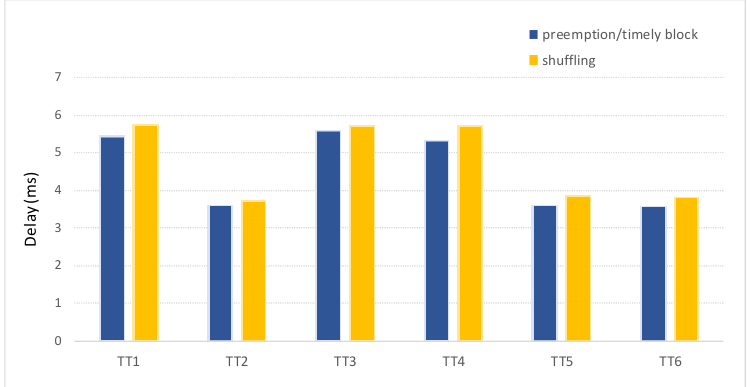
Figure 12. Worst-case delay under different traffic integration